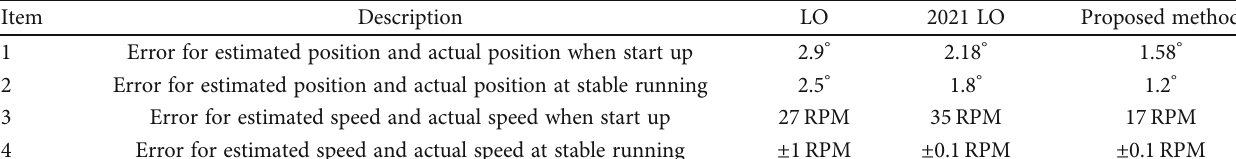
Table 8: Performance comparison of PMSM sensorless control system.